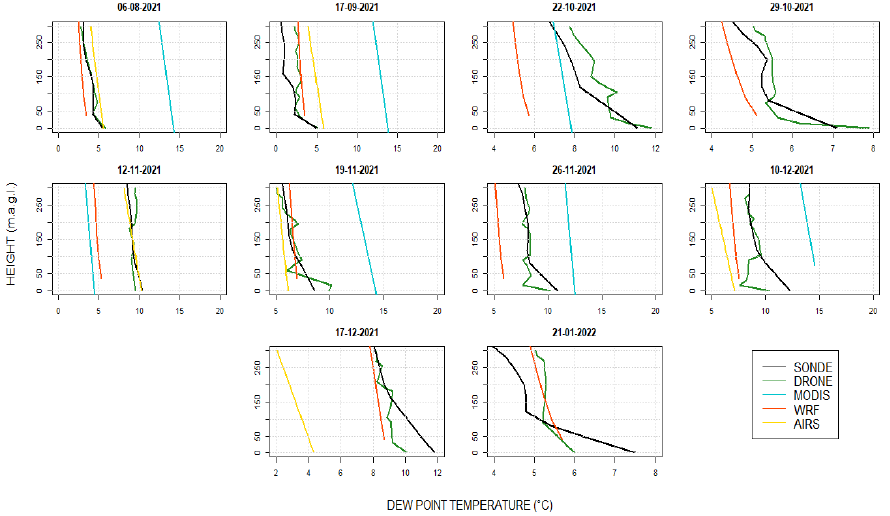
Figure 4. Dewpoint temperature profiles measured with radiosonde (black), drone (green), MODIS (sky-blue), AIRS (yellow), and WRF (orange) up to 300 magl. for 10 measurement events.